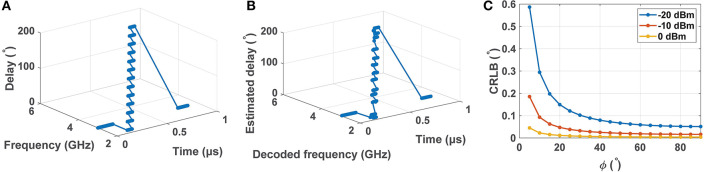
Simulation showing tracking of a rapidly moving source with frequencies and ITDs increasing from 2 to 5 GHz and 0 to π rad, respectively: (A) actual trajectory, and (B) estimated trajectory for SNR = 20 dB. (C) Calculated Cramer–Rao lower bound (CRLB) for the angle of arrival (AOA) estimation (in degrees) at 3 GHz as a function of source position ϕ for various input power levels.